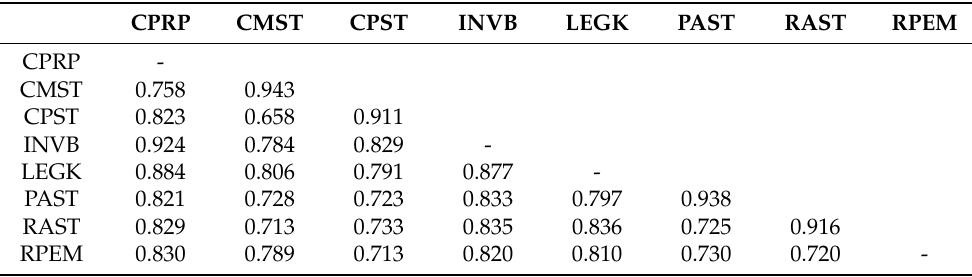
Table 3. Fornell–Larcker criteria.